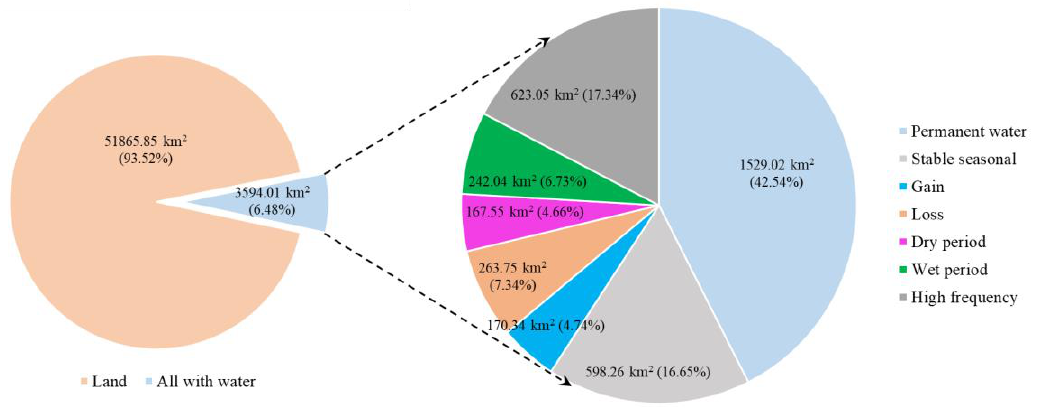
Figure 10. The total area and proportion statistical results for eight surface water dynamic types: land, permanent water, stable seasonal, gain, loss, dry period, wet period and high frequency.